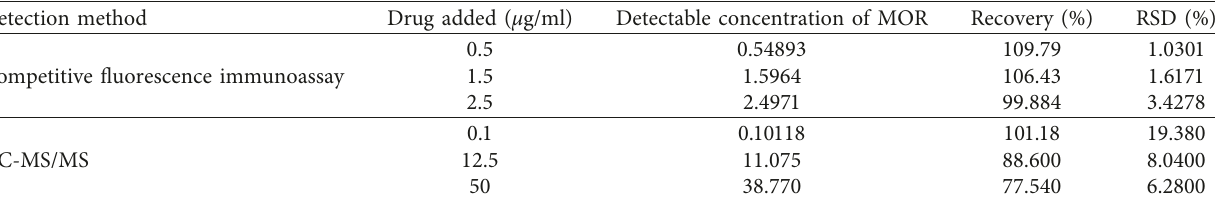
Table 2: Standard addition results of MOR in urine samples ( n